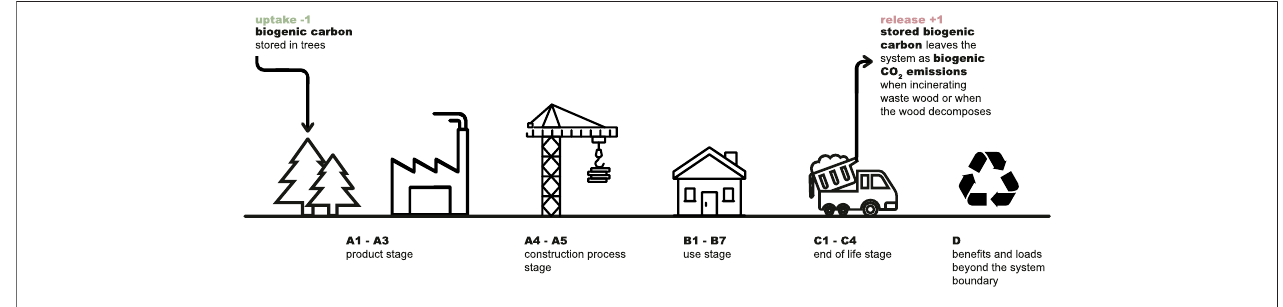
FIGURE 2 | Overview of biogenic carbon counting in a building life cycle according to the − 1/+1 approach.